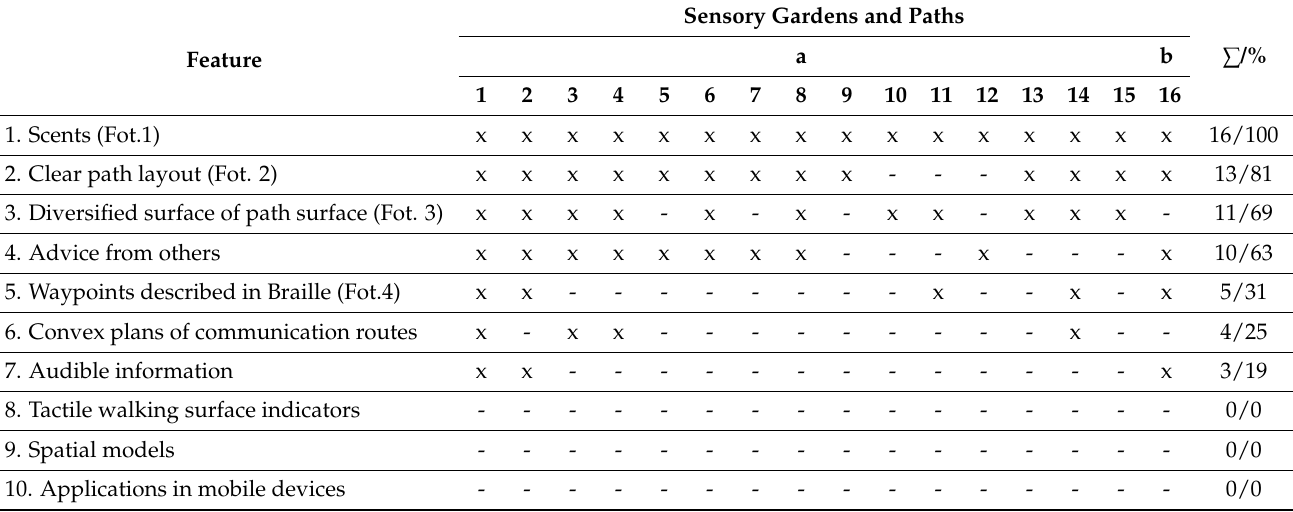
Table 2. Elements in the sensory garden to facilitate spatial orientation.